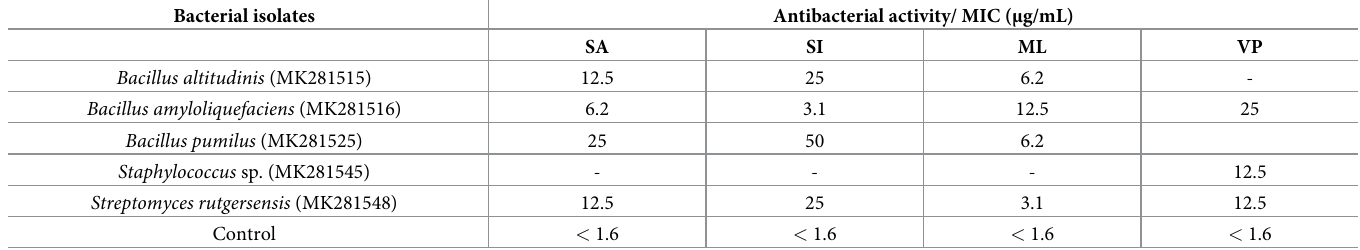
Table 6. The MIC value was determined by selecting strains with primary screen activity and bacteriostasis circle more than 1.5 cm. ( Bacillus altitudinis, Bacillus amyloliquefaciens, Bacillus pumilus, Staphylococcus sp., Streptomyces rutgersensis